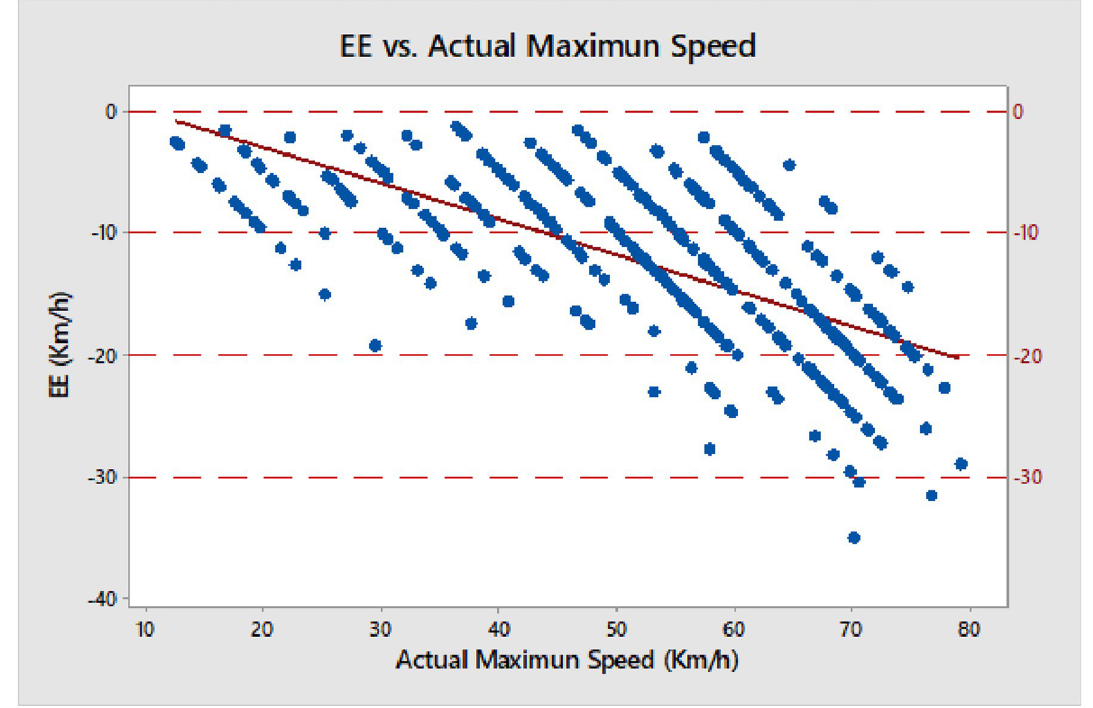
Fig 1. Error of estimation (EE; Y axis) with regard to skiing actual maximum speed (X axis). Parallel lines of data are due to participants estimating their maximum speed in steps of ± 5 km/h.